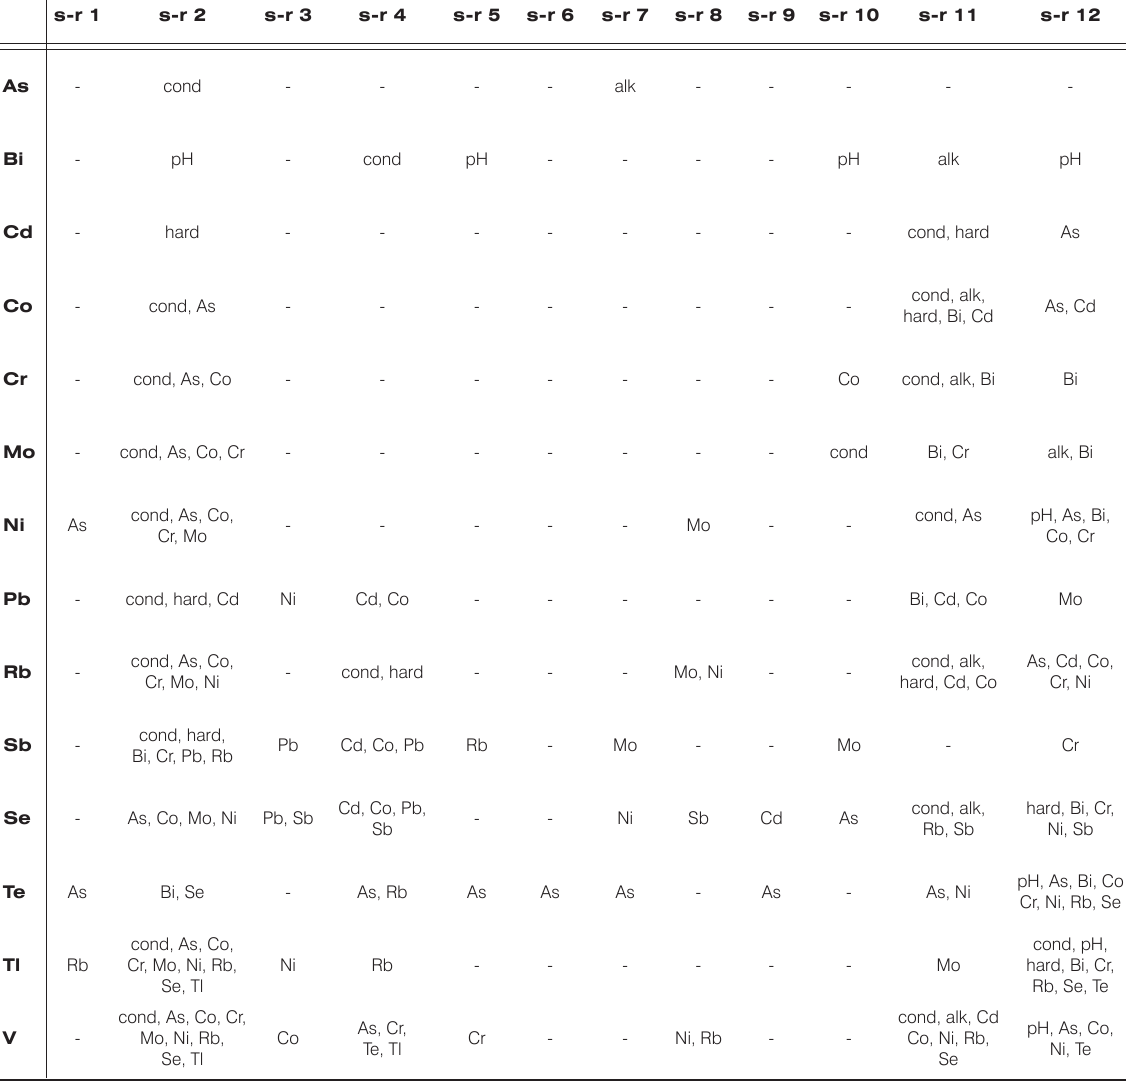
Table 8. The most important explanatory variables selected on the basis of an analysis of the Pearson coefficients of correlation values (r ≥ 0.65); „-” means no correlation, s-r – sub-region